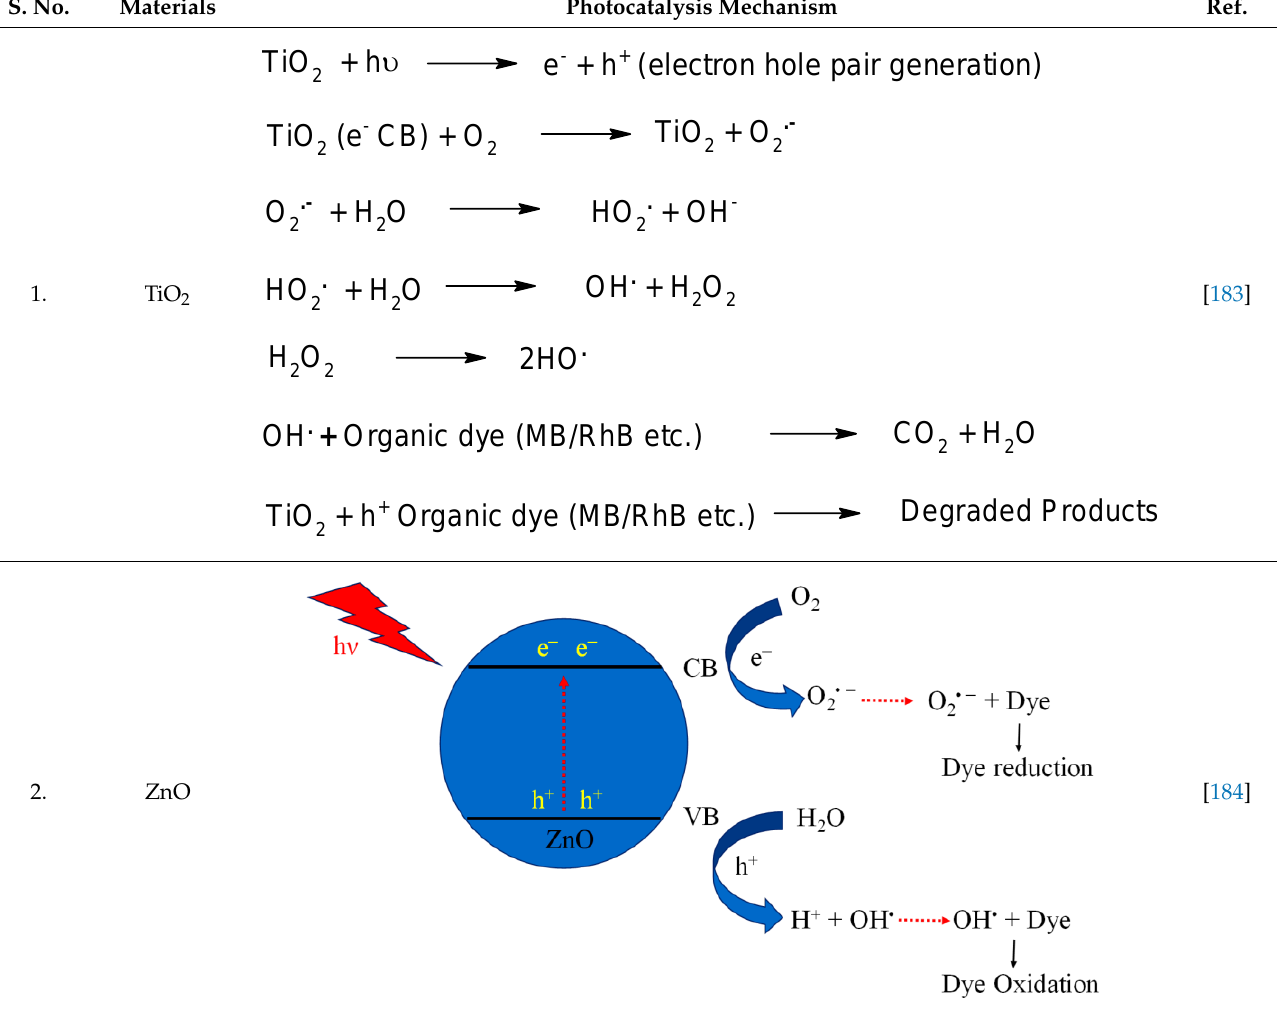
Figure 11. Comparative photocatalytic activity among different photocatalysts based on degradation time. Table 6. Mechanism of photocatalysis for TiO 2 , ZnO, Ag 3 PO 4 , CdS and ZnTiO 3 photocatalysts nanomaterials photocatalysts.